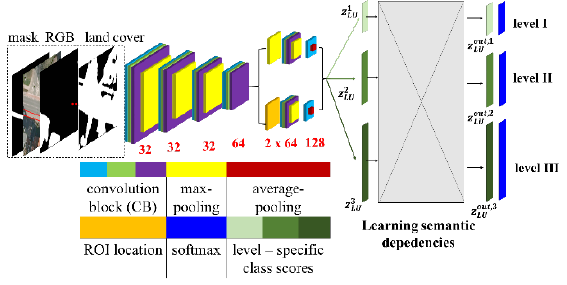
Figure 3: Architecture of LuNet-lite-JO . The red numbers indicate the number of filters per layer. More details are given in the main